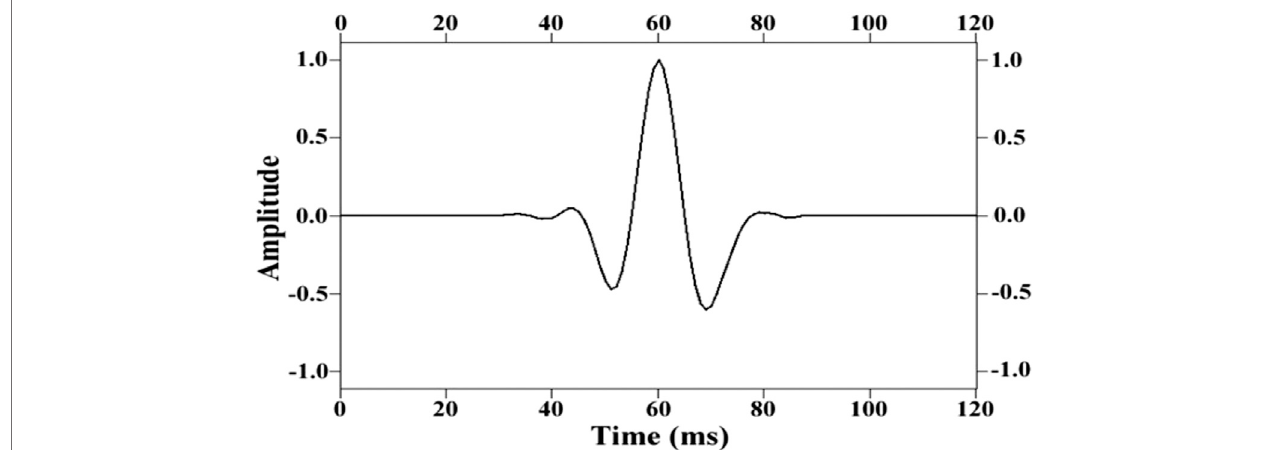
FIGURE 10 | Source wavelet.